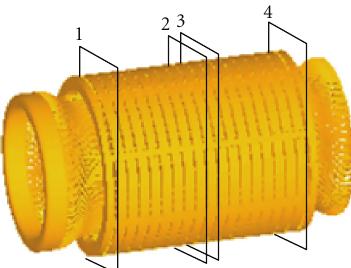
Figure 3: Schematic illustration of each cross section for the rotor and